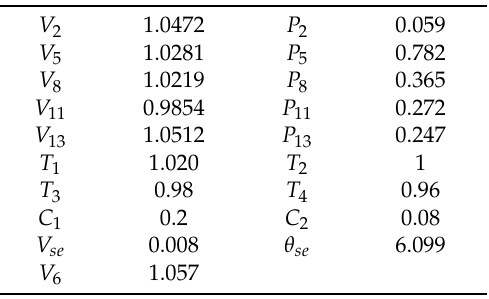
Table 5. The optimized system control parameters in Case A.